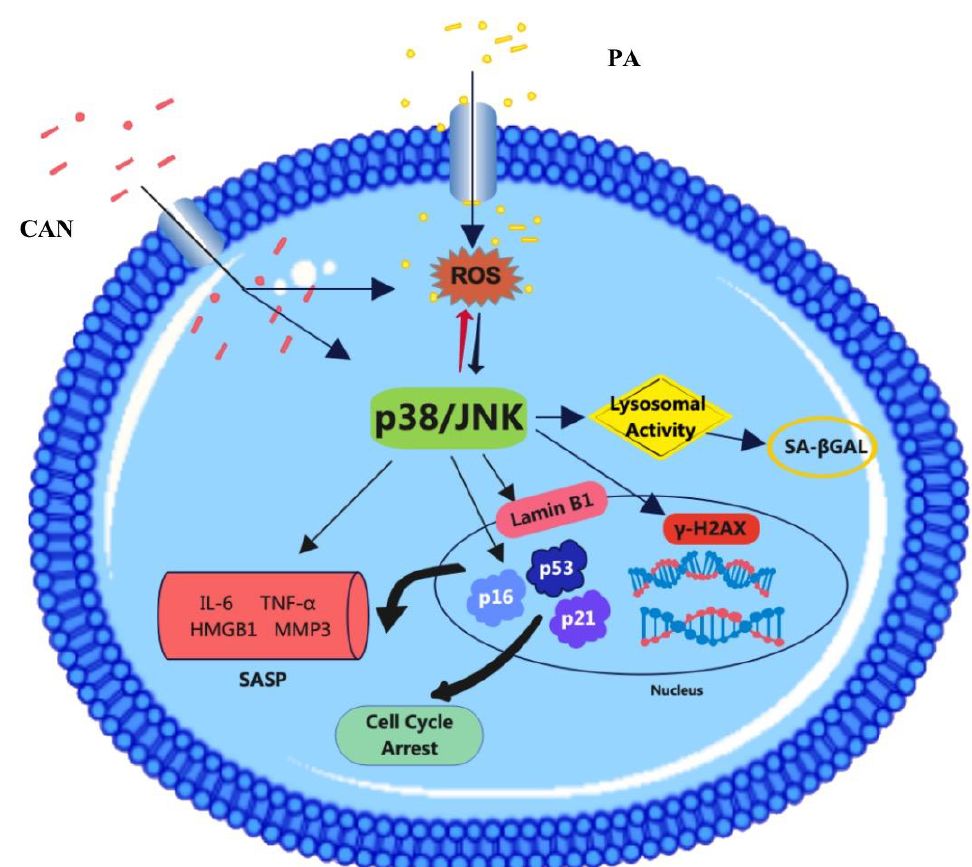
Figure 12. CAN inhibits PA-induced replicative cellular senescence via the ROS/p38/JNK